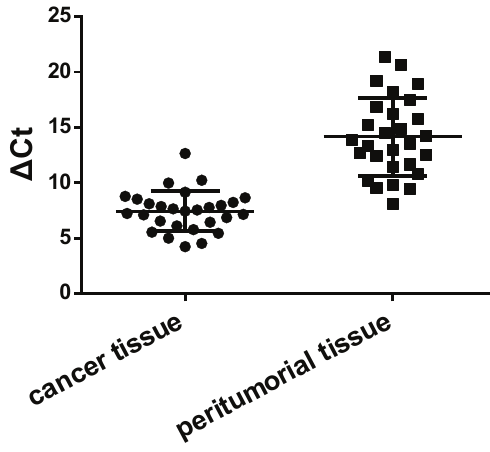
Figure 2 : Expression of PD-L1 mRNA in cancer tissue and peritumo- rial